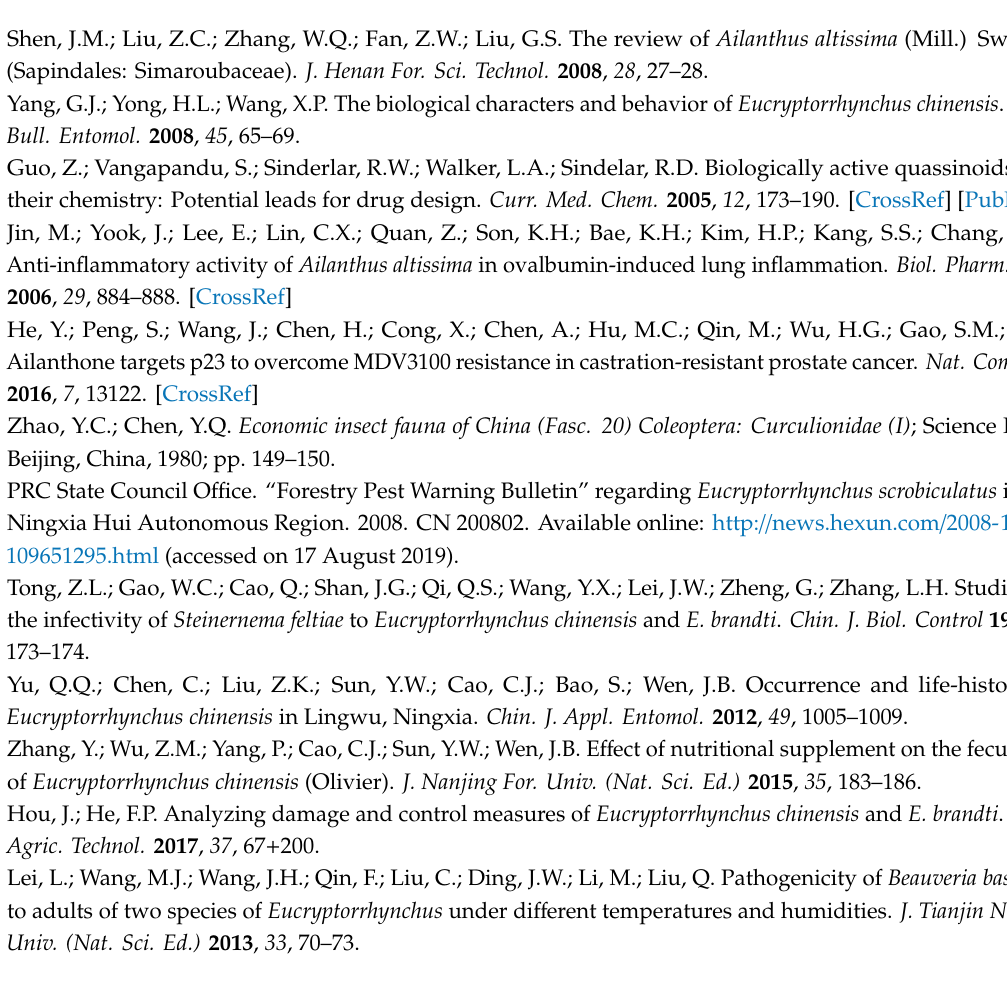
Figure S1: Fourth instar nymph Lycorma delicatula captured in a TTN, Figure S2: Adult Lycorma delicatula captured in a